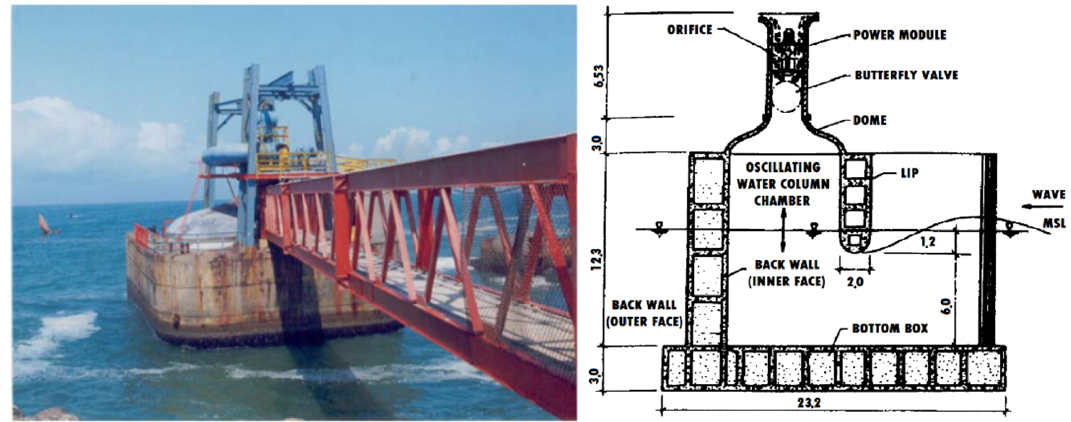
Figure 9. Photo ( left , reproduced with permission 5152420320606 from [48], Elsevier, 2018) and section view ( right , adapted with permission 5152420556915, from [49], Elsevier, 1997) of the OWC device at Vizhinjam.